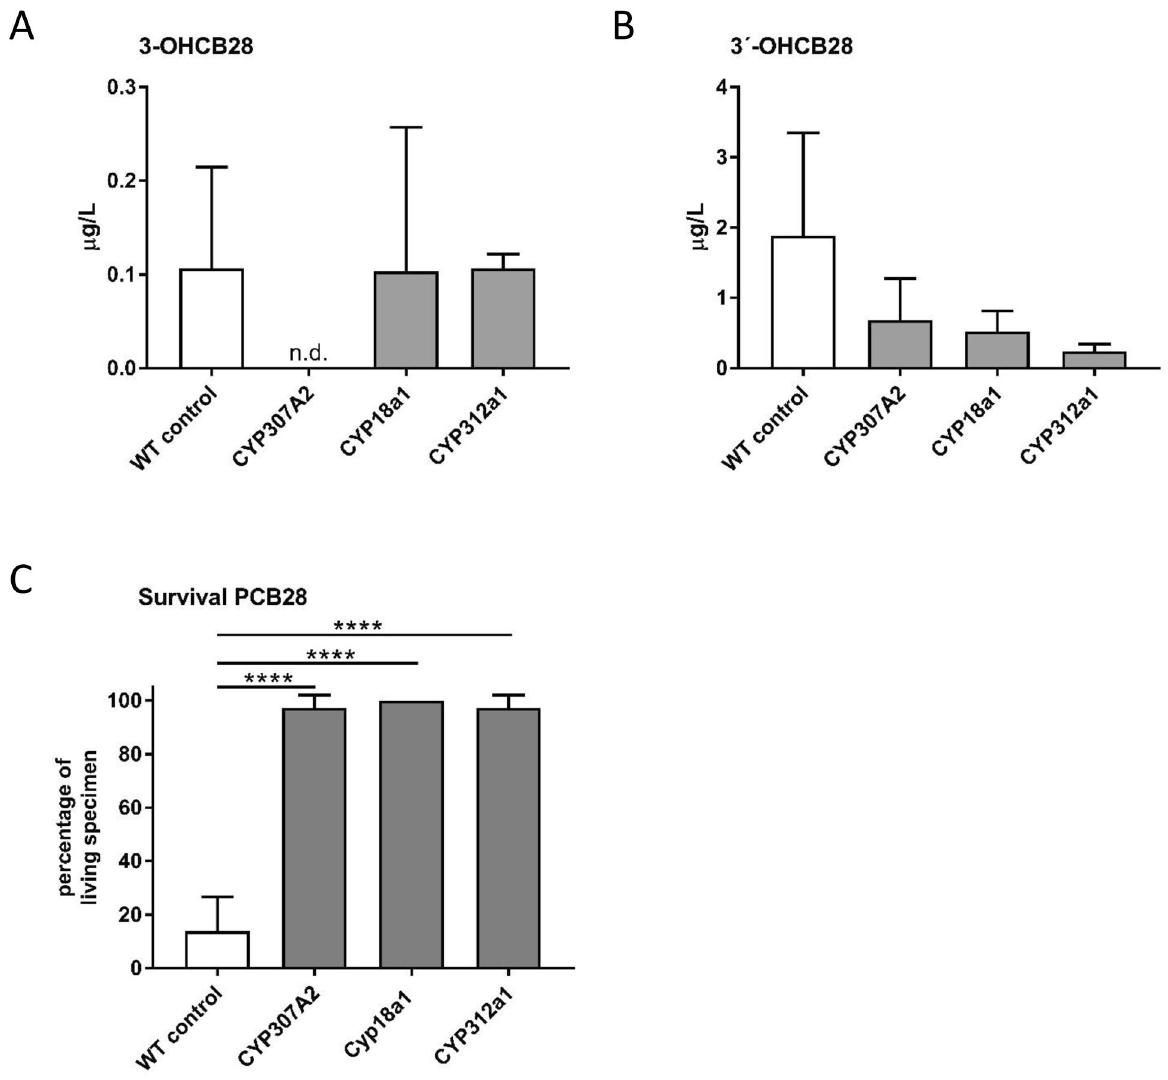
Figure 2. Metabolism of PCB 28 in Drosophila pairings with knockdowns in either CYP307a2, 18a1 or 312a1 compared to WT Canton-S. Flies were generated and treated as described in Table 1. The amount of 3-OH- CB28 ( A ) and 3´-OH-CB28 ( B ) in WT Canton-S or Drosophila with knockdowns of Cyp307a2, Cyp18a1 or Cyp312a1. ( C ) Survival rate of the respective Drosophila specimen at high PCB 28 concentrations. Mean ± SD of 3 different biological experiments each with 3 technical replicates are shown (each technical replicate corresponds to 12 flies). Differences were calculated by repeated measurement ANOVA and posthoc Tukey-test. ( A , B ) differences are not significant. Figure C control versus knockdowns of Cyp307a2, Cyp18a1 or Cyp312a1; p ≤